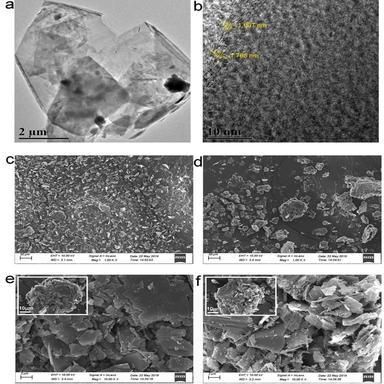
TEM images of (a) (b) raw MG; SEM images of (c) raw MG, (d) (e) MMC1, and (f) MMC3.